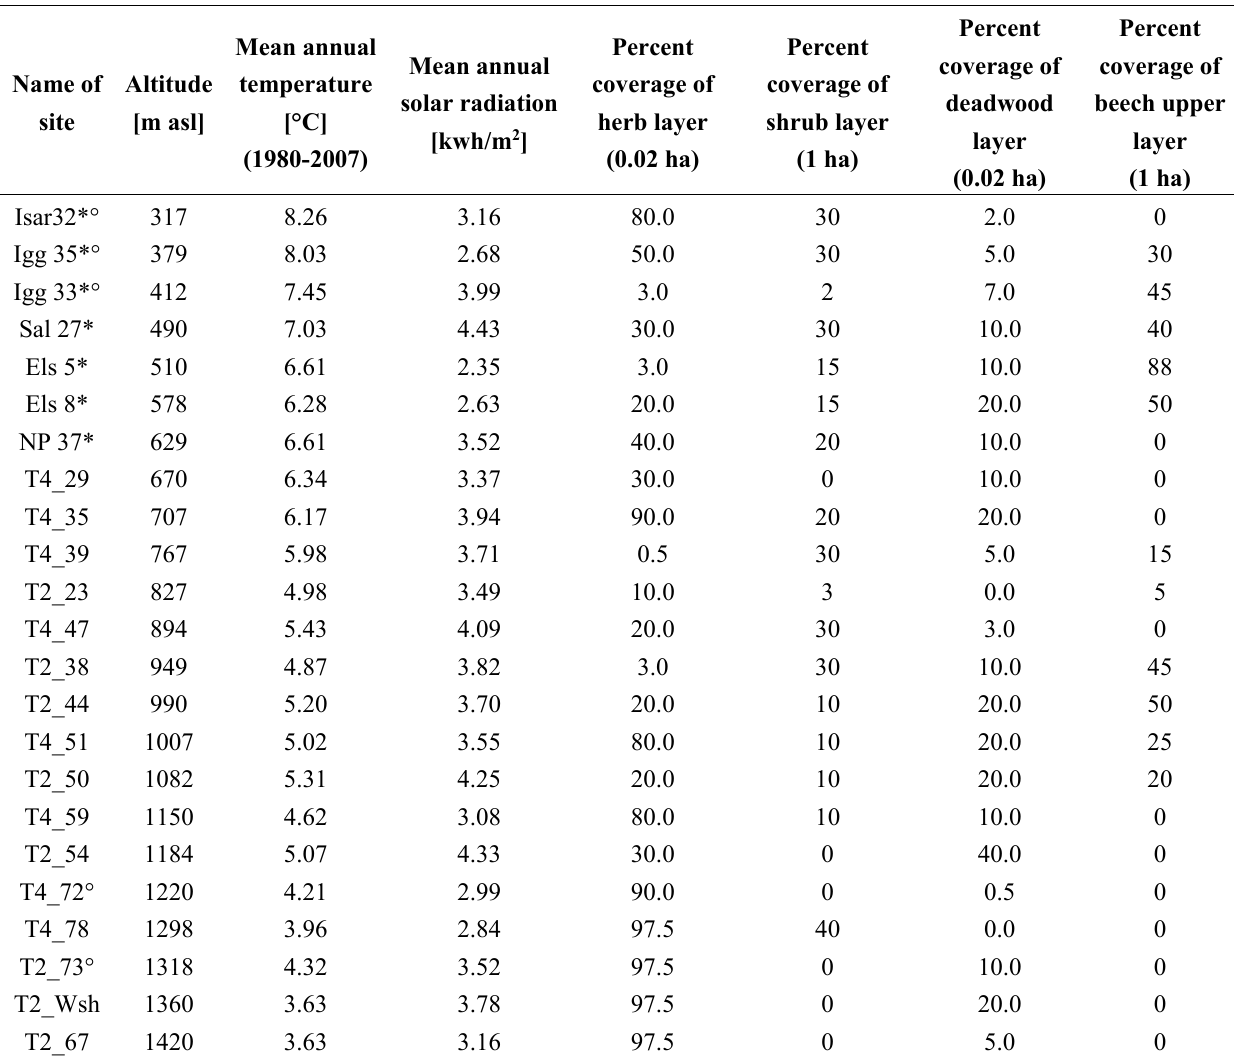
Table 2. Environmental and climatic variables at the 23 trapping sites in the BFNP. As trapping indices and diversity indices change for each trapping event these are not shown in the table. * marks trapping sites of Donau (DO, Danube) transsect, ° marks sites where no PUUV seroreactivity could be found in M. glareolus